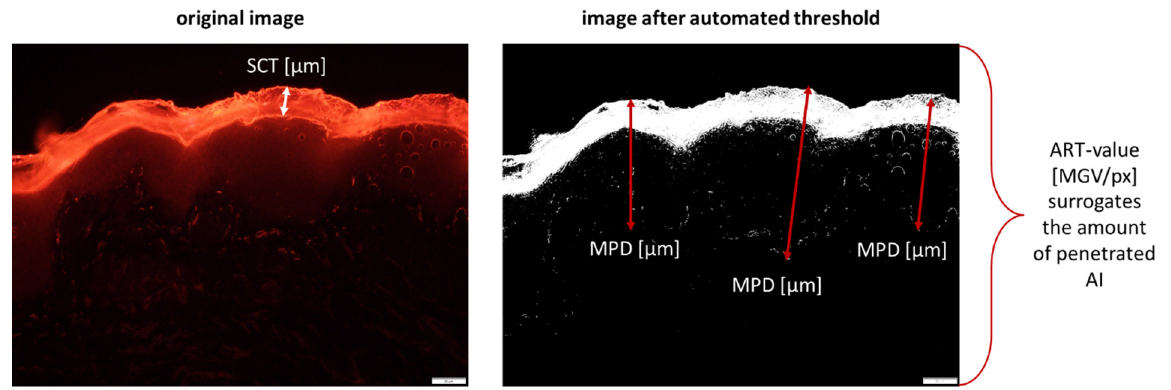
Figure 2. Overview of the parameters assessed with digital image analysis. SCT = stratum corneum thickness, MPD = mean penetration depth, ART = autofluorescence of image after RGB threshold.